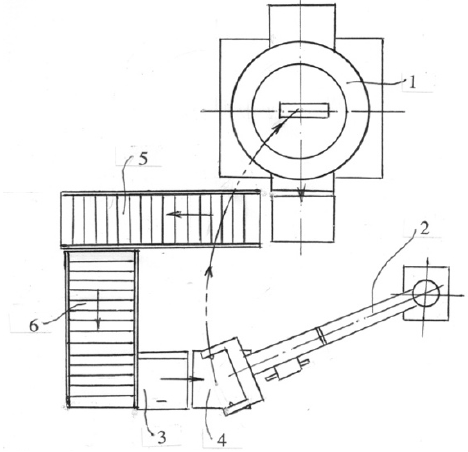
Figure 9. An ECAE processing line with a manipulator.